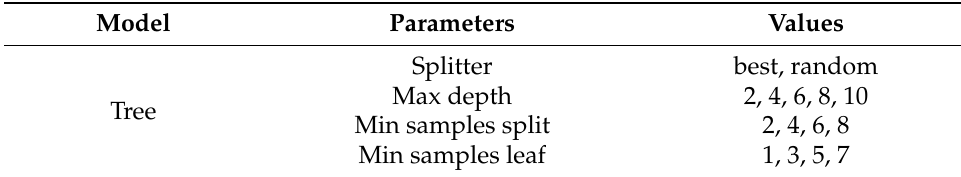
Table 6. Grid of parameters used for regression tree models.